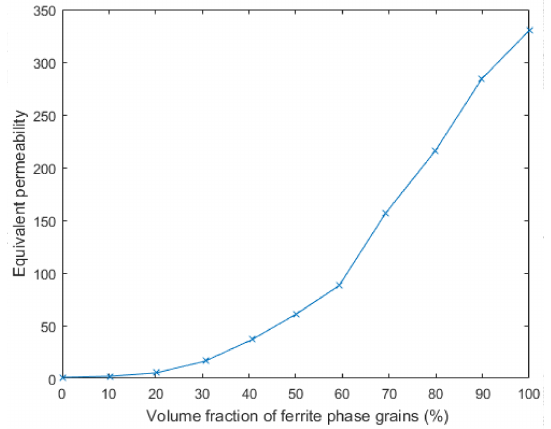
Figure 5. Equivalent relative permeability of austenite–ferrite in the RCPS-VM microstructure with varying phase fractions.